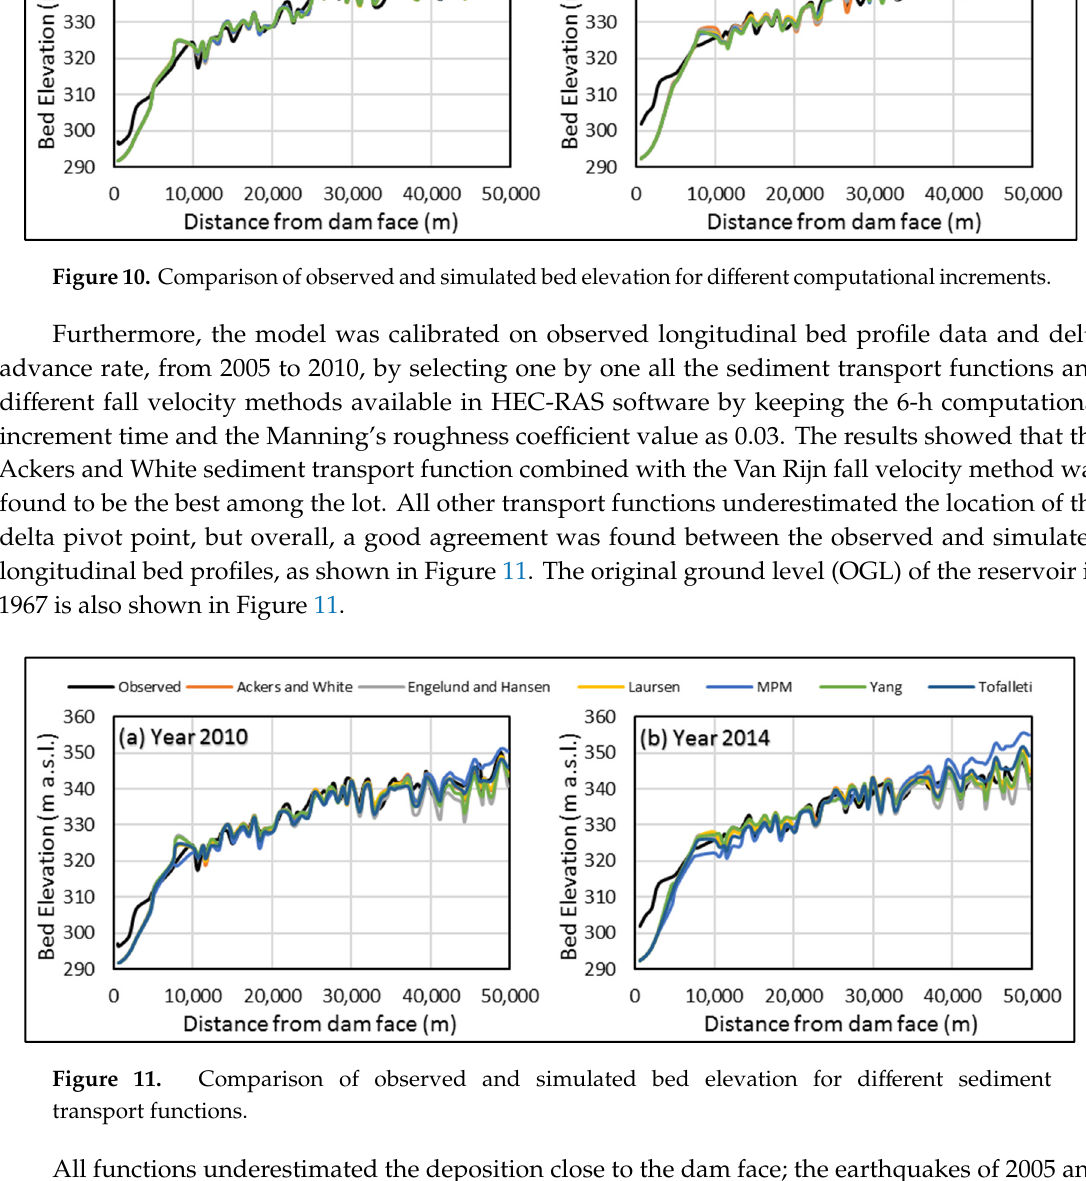
Figure 12. Calibration of the numerical model for the year 2010. Model Validation The numerical model was validated for the years 2014 and 2017 by comparing the computed and observed longitudinal bed profiles of the reservoir, as illustrated in Figure 13. From Figure 13, it is revealed that the topset slope closely matches the topset slope of the observed delta profile. A fairly good agreement was found between the simulated and observed measurement of the bed profile exclusively on the far and near of the topset slope and on the pivot point of the sediment delta. However, minor discrepancies have been observed on locations where the river channel is narrow and on the river bends. This is due to the presence of 3D effects, i.e., helical flow due to secondary currents, which can only be resolved by a 3D flow and sediment model [18]. Further, the model underestimated the sediment deposition close to the dam embankment. Overall, the results of the calibration and validation of the numerical model indicate that the model was able to compute the bed levels with reasonable accuracy, thus pointing to its suitability for the reservoir sedimentation studies.